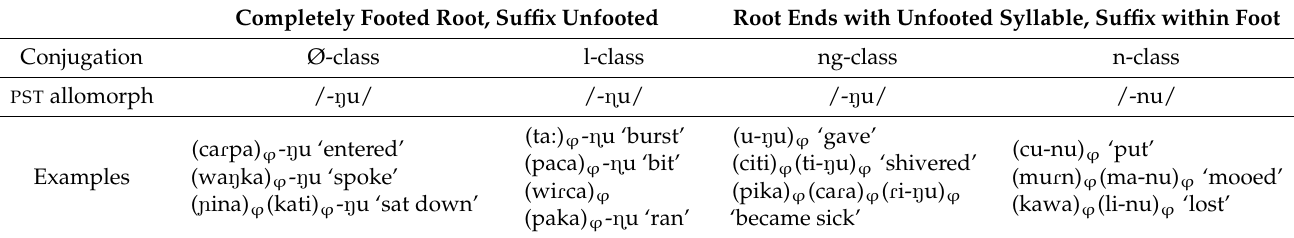
Table 2. Allomorphy of past tense